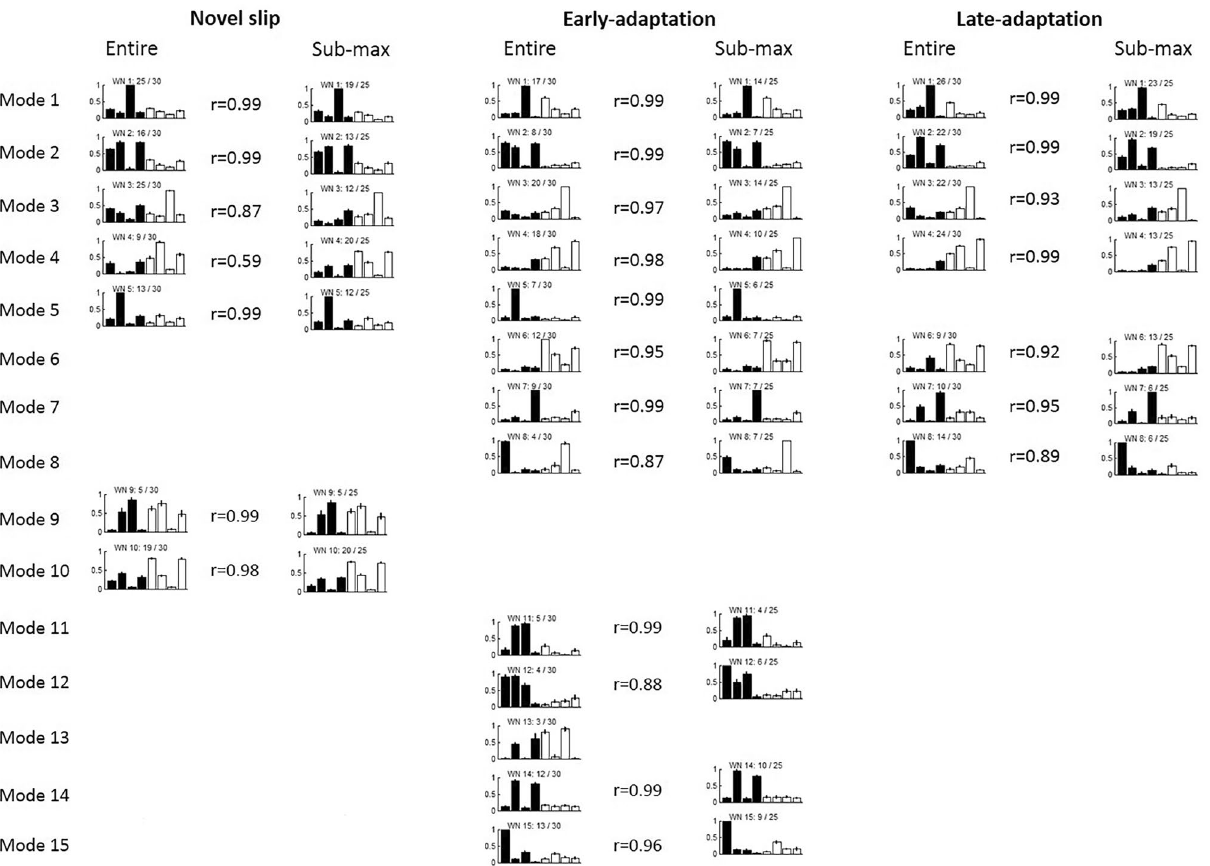
Figure 6. The comparison of clustered muscle synergies between entire dataset and sub-maximum (25 out of 30)